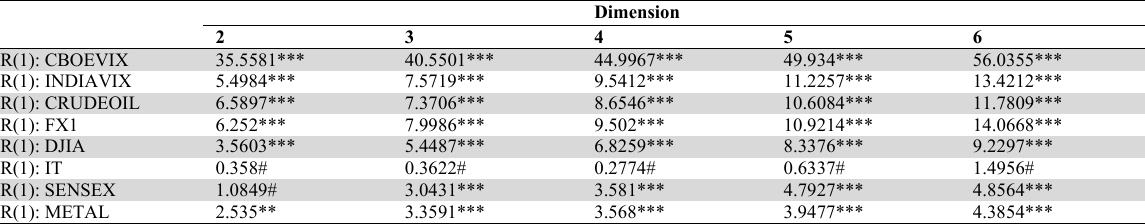
Table 2 BDS Test